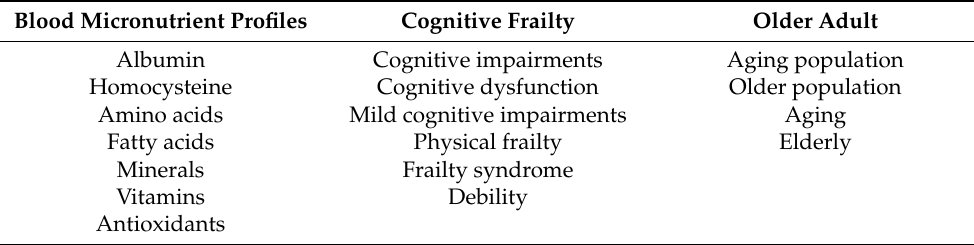
Table 2. List of search strings.